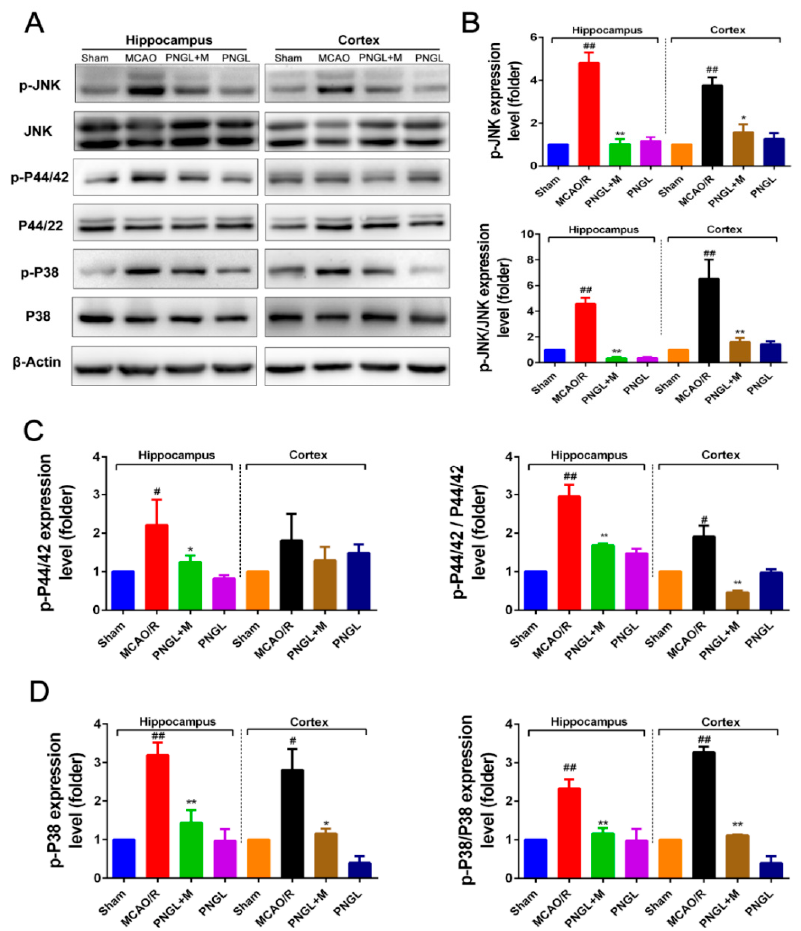
Figure 8. Effects of PNGL on the expression levels of phosphorylated P44/42, JNK1/2, and P38 of MAPKs signaling pathway in the ischemic brain. PNGL downregulated the expression levels of phosphorylated P44/42, JNK1/2, and P38 of MAPKs. ( A ) The protein bands of phospho-ERK, phospho-P38, and phospho-JNK, respectively, in the ischemic brain sections were examined by western blot analysis. ( B )–( D ) The relative expression levels of phosphorylated P44/42, JNK1/2, and P38, respectively, were quantified and analyzed by using Gel-Pro analyzer software. Mean values ± SEM ( n = 3); p < 0.05, ** p < 0.01, versus MCAO/R group; # p < 0.05, ## p <0.01 versus sham-operated group.